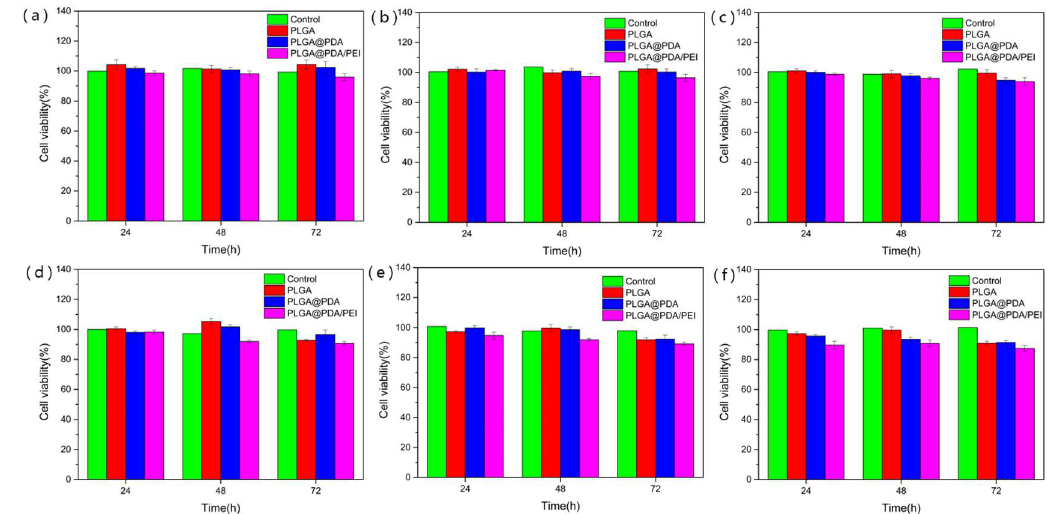
Figure 9. Cell viability after treatment with blank PLGA, PLGA@PDA and PLGA@PDA/PEI microspheres at the concentration of ( a ) 37.25 µg/mL; ( b ) 62.5 µg/mL; ( c ) 125 µg/mL; ( d ) 250 µg/mL; ( e ) 500 µg/mL and ( f ) 1000 µg/mL.